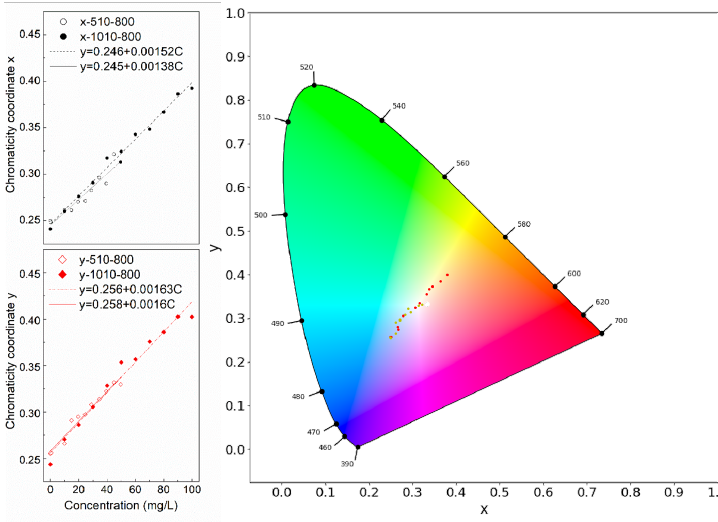
Figure 5. The xy values of different humic acid concentrations in the xy chromatic diagram. The left figure shows a linear relationship simulation between chromaticity x or y values and humic acid concentration.